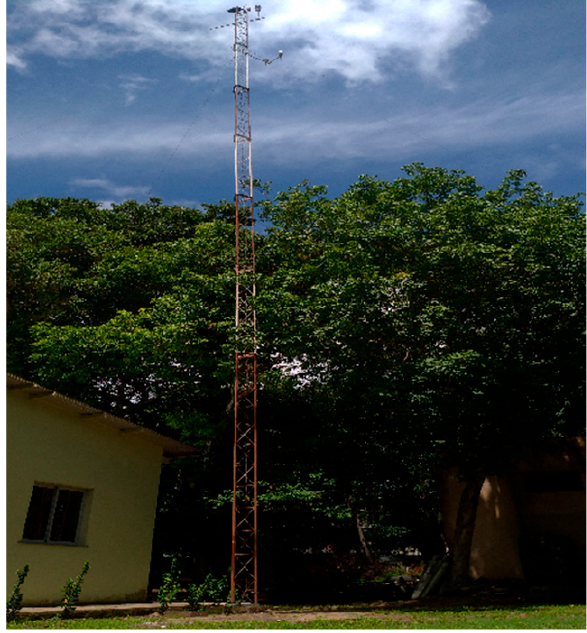
Figure 2. Tower where the UVR sensor was installed.